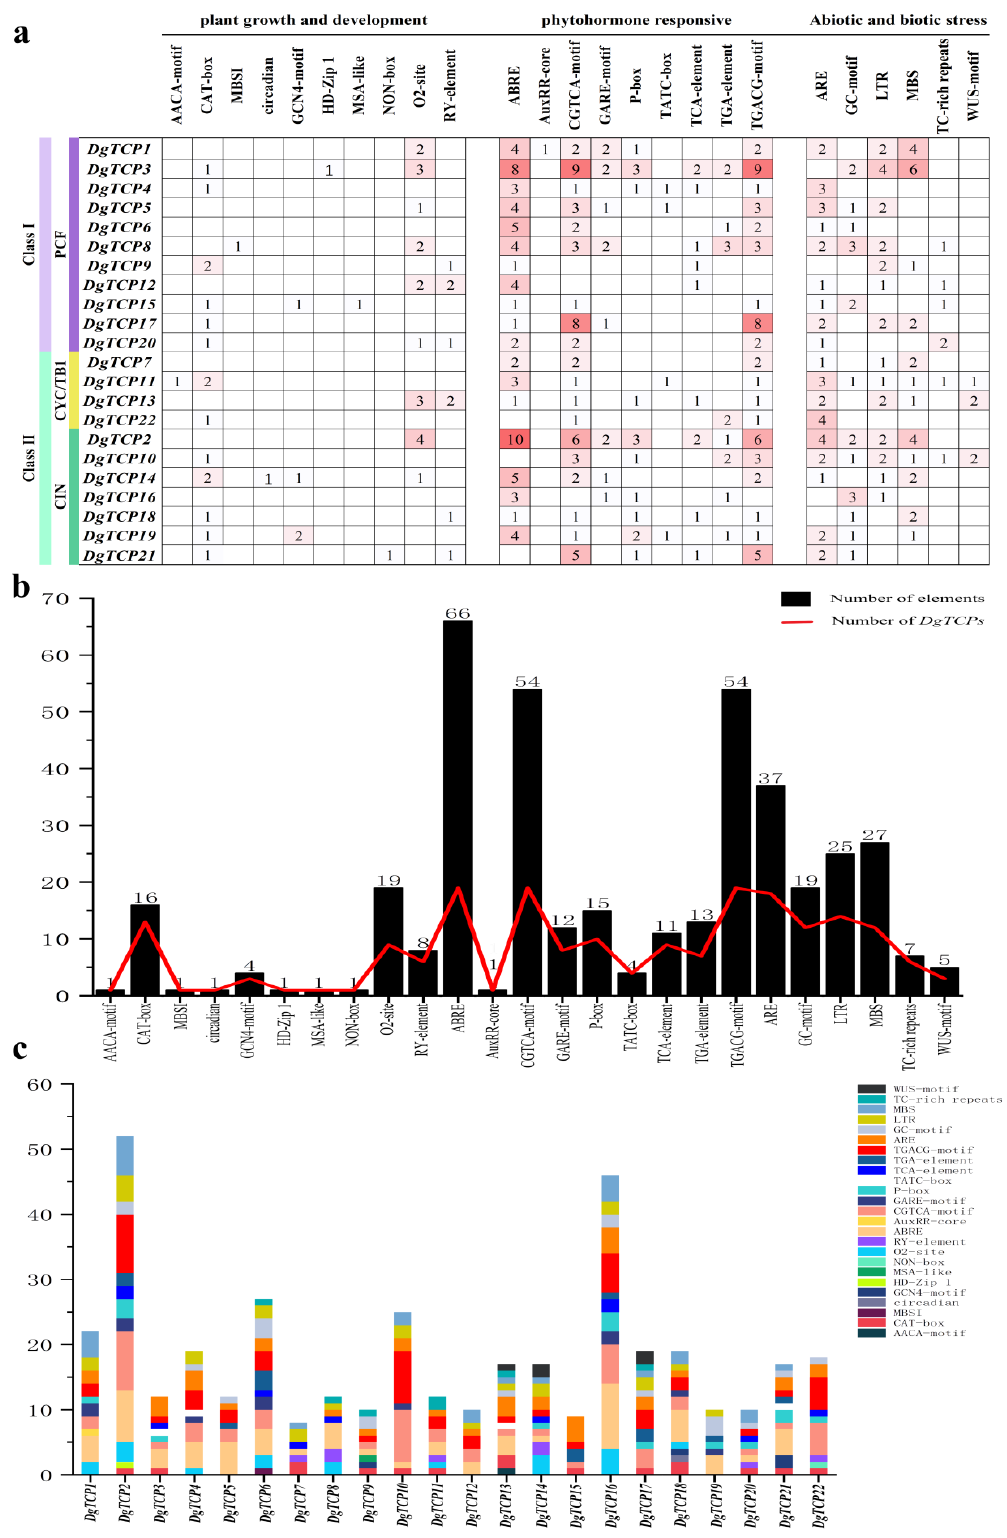
Figure 7. Cis-elements in the promoter regions of the DgTCP genes. ( a ) The cis-elements in the DgTCP promoter regions. ( b ) The number of DgTCPs and corresponding cis-elements (red line) and the total number of cis-elements in the DgTCP gene family (black box). ( c ) The number of cis-elements (from the promoter regions of each DgTCP) associated with plant growth and development, phytohormone, and stress